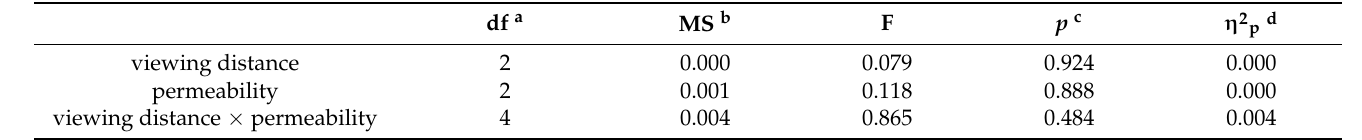
Table 3. Impacts of different viewing distances and permeability levels on (cid:52) E SC.